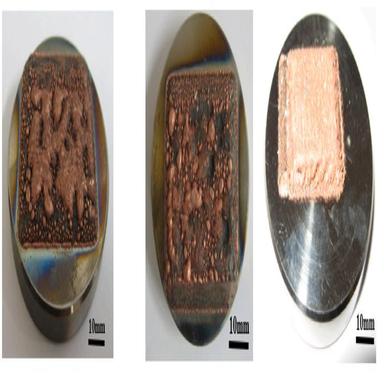
LDED Deposited Cu bulk at constant LEPF scheme (a) 9 kJ/g (b)12 kJ/g (c)15 kJ/g (d) 22.5 kJ/g.